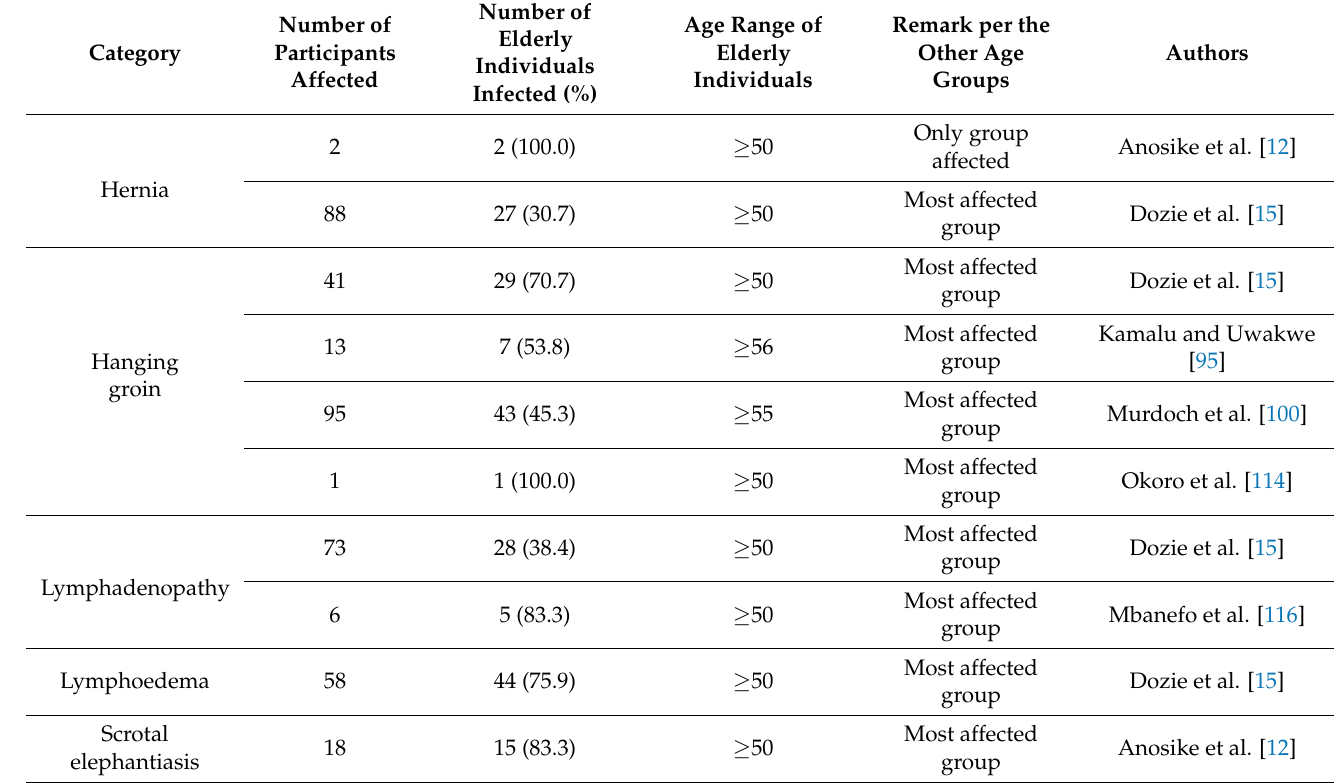
Table 2. Distribution of lymphatic complications in the older